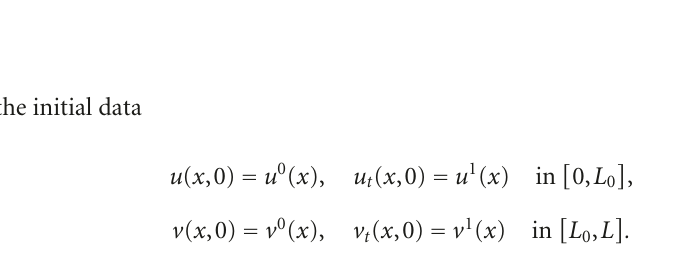
Figure 1.1. A composite beam on an elastic